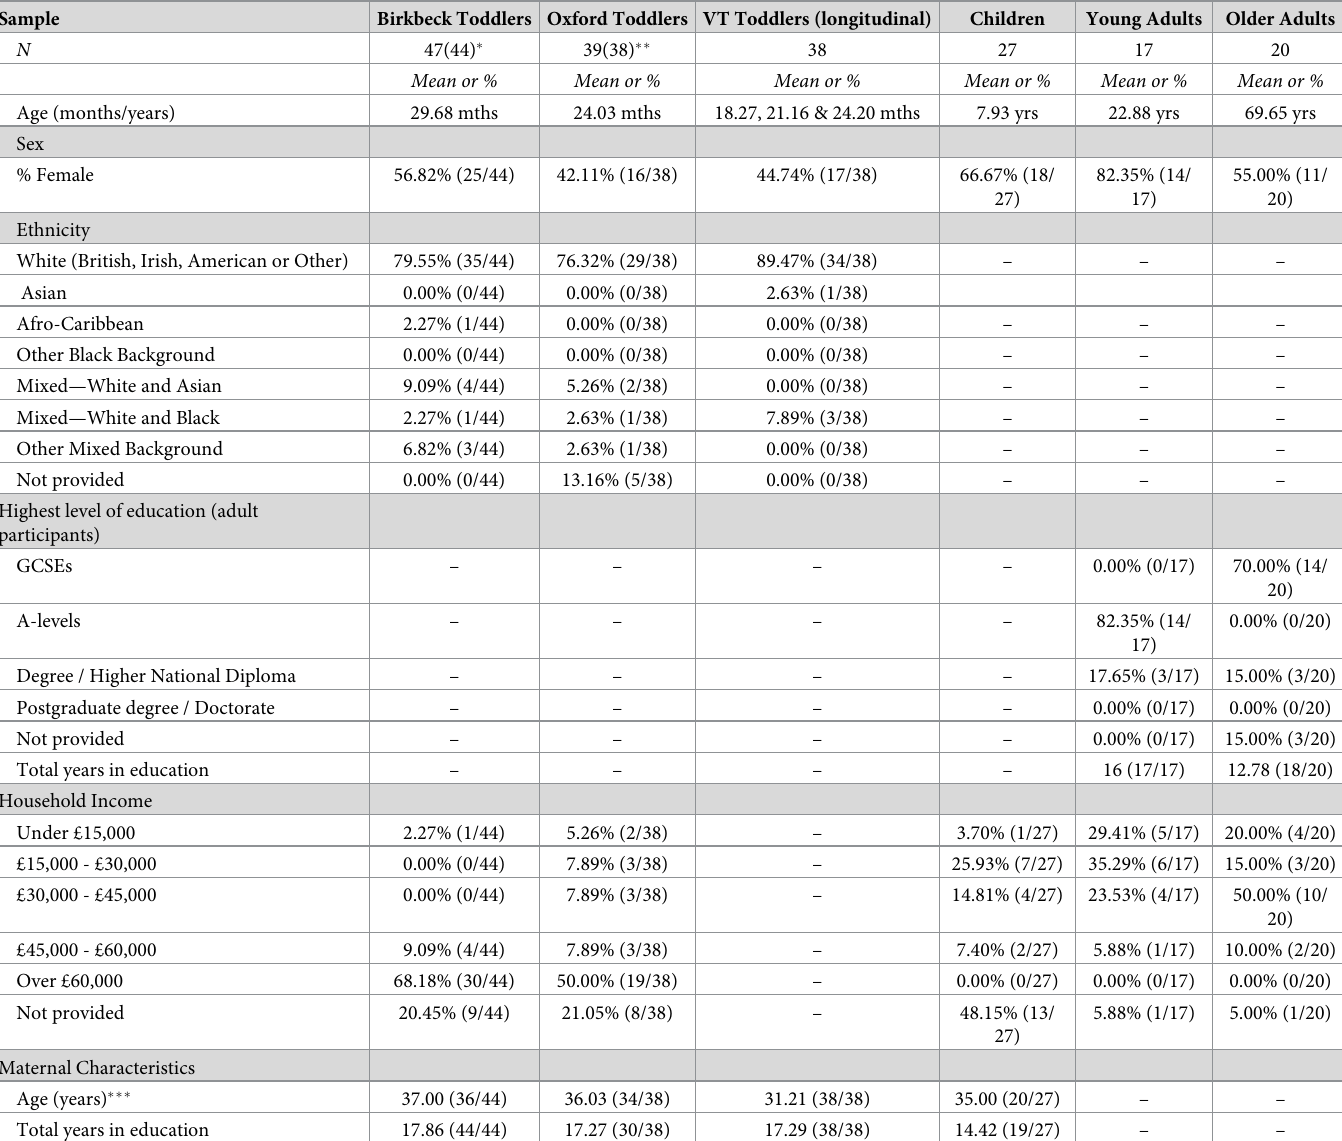
Table 1. Demographic information for participants in Studies 1, 2 and 3.